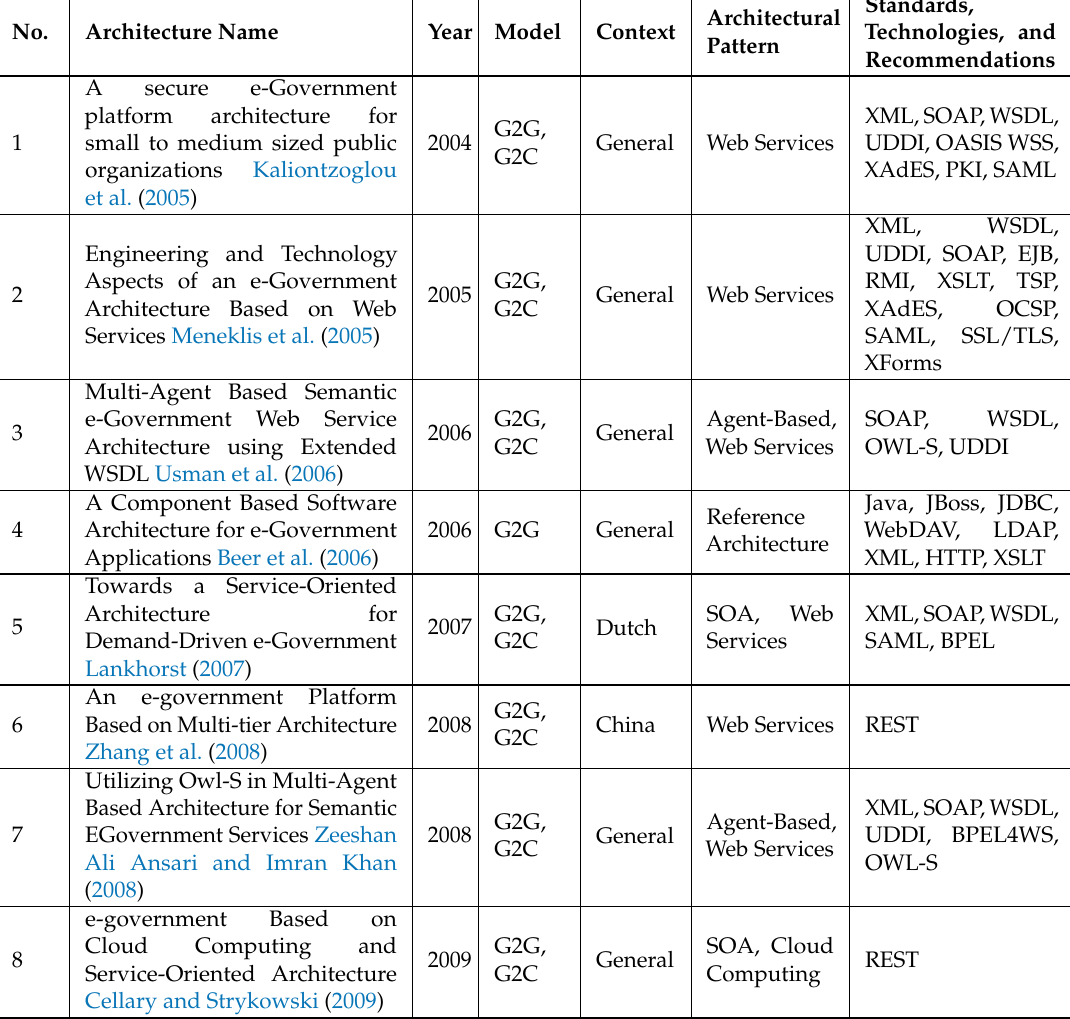
Table 3. Summary of existing Digital Government